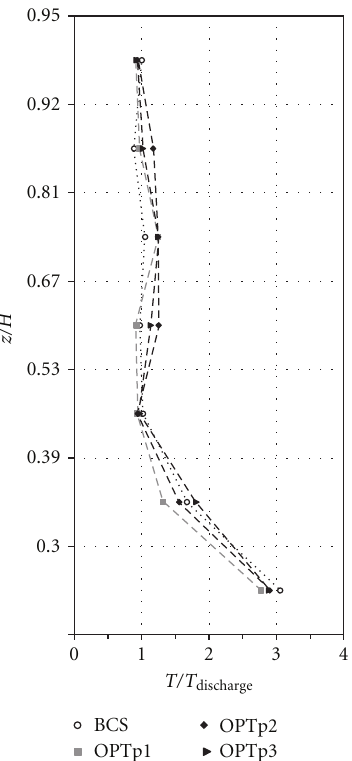
Figure 5: Comparative profiles of nondimensional air temperature, T/T discharge ( y/W = 0 . 44, z/H ), in the conservation zone—OPTp cases